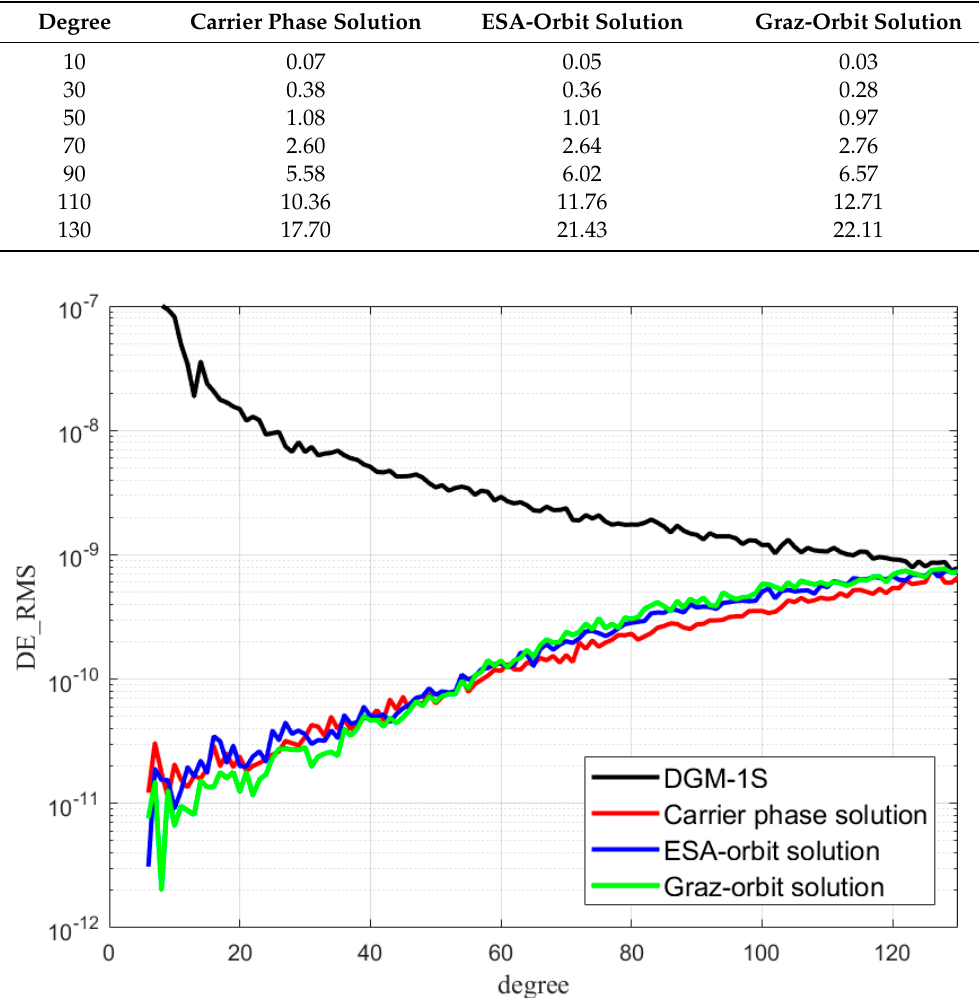
Table 7. Cumulative geoid height di ff erences (unit: cm) w.r.t. DGM-1S up to di ff erent degrees.